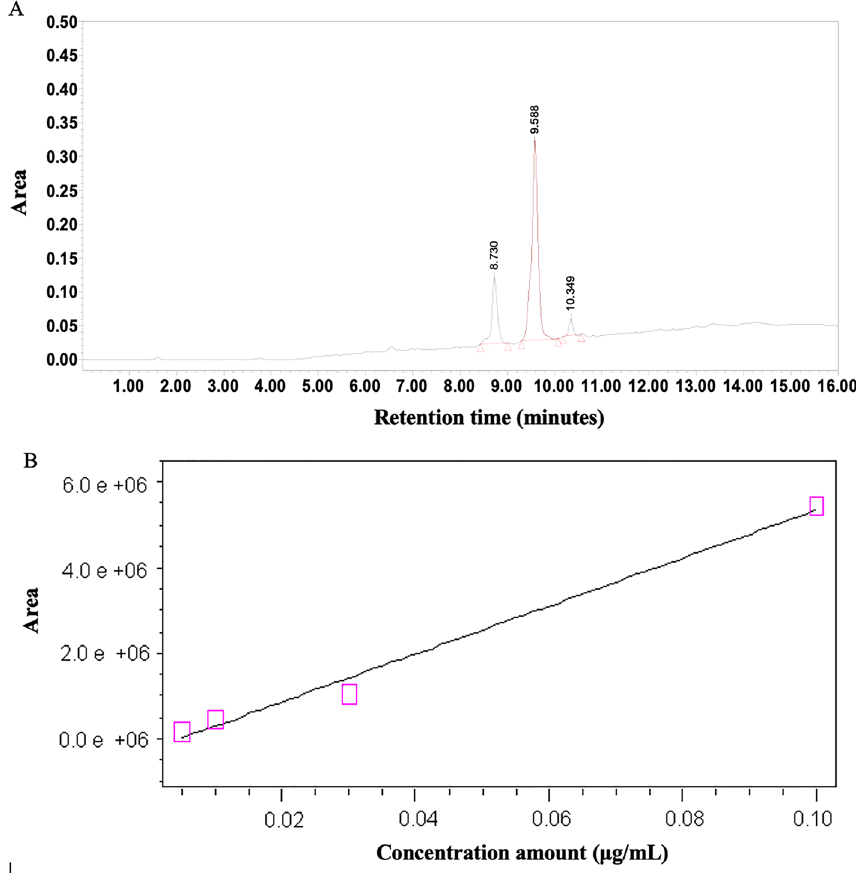
Figure 2. HPLC results of crude extract of Alhagi maurorum . ( A ) Result of crude extract, ( B ) Calibration curve of quercetin using HPLC analysis method.